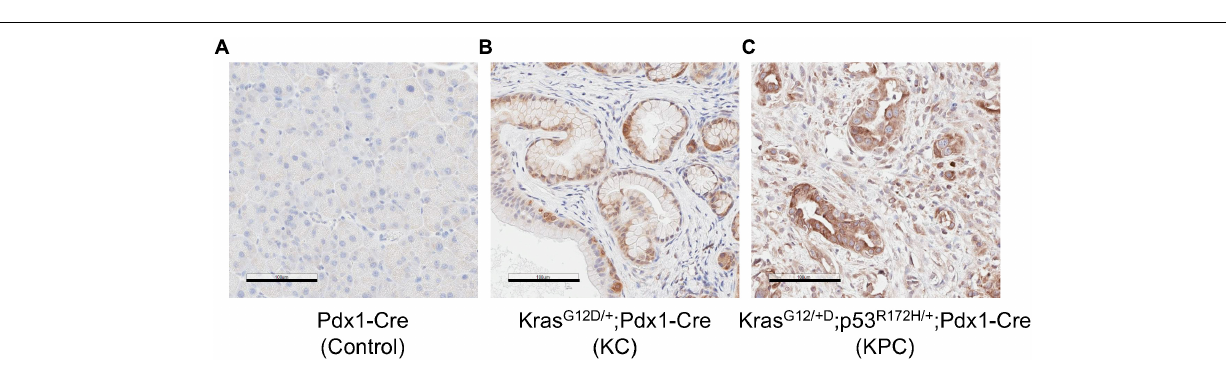
FIGURE 5 | MSP expression in mouse pancreatic tissues. IHC analysis of mouse pancreatic tissues using anti-MSP antibody. (A) control (Pdx1-Cre); (B) KC mice (LSL-KRAS G 12 D / + ; Pdx1-Cre); or (C) KPC mice (LSL-KRAS G 12 D / + ; LSL-p53 R 172 H / + ; Pdx1-Cre). Magnification: 20 × ; Scale bar: 100 µ